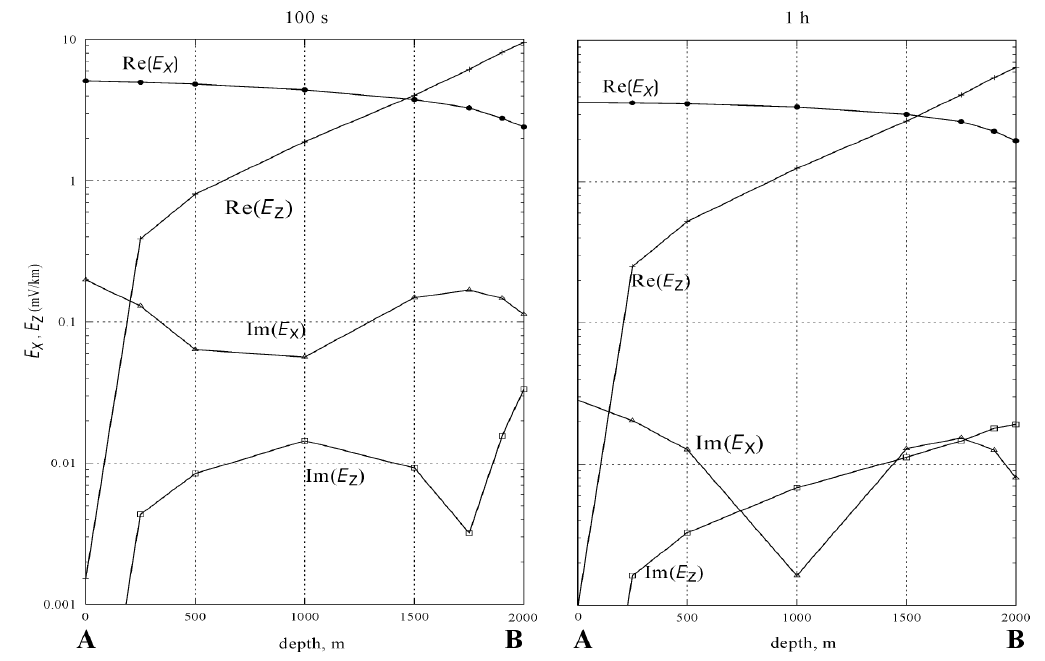
Fig. 4. Electric field components E z and E x along profile A - B . The source is E x -polarized plane wave. The re- sults are presented for periods 100 s ( left panel) and for 1 h ( right panel). The fault resistivity is 10 Ω⋅